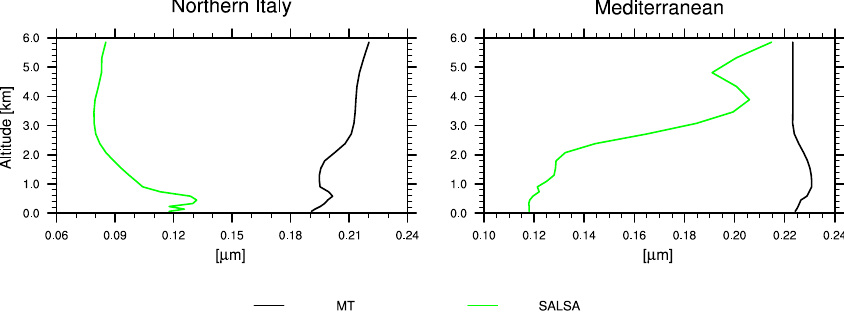
Figure 7. Effective radius, r eff , for the two chemical transport model versions MT and SALSA over northern Italy and the Mediterranean on 22 June 2007 at